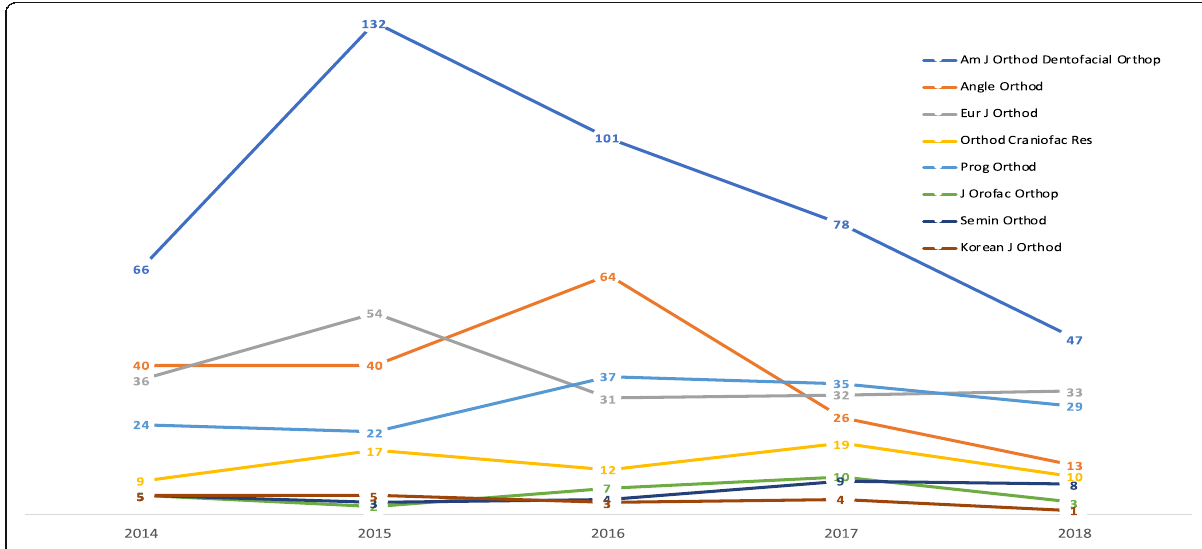
Fig. 2 Evolution of the published items with online activity (articles with a positive AAS) from the years 2014 to 2018 in each of the selected journals. The Australian Orthodontic Journal does not appear since only one item displayed a positive AAS in the studied